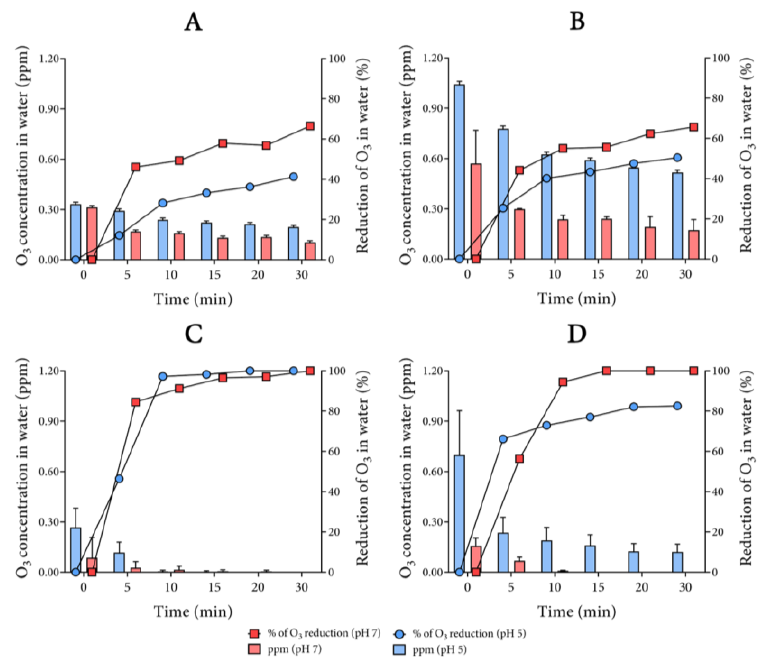
Figure 2. Ozone stability curves in ultrapure water. Ozonation of non-buffered ultrapure water at 25 °C ( A ) and 4 °C ( B ). The left y-axis is fitted the mean with standard deviation for the concentration in parts per million (ppm). The right y-axis is fitted the percentage of the O 3 reduction in water. Both displayed y-axes were obtained from the same experiment. The percentage of O 3 reduction in water was calculated considering the first sample (0 min) as the basis. Adjustment of pH was performed with 1 M HCl. Ozonation of buffered (PB, 20 mM) ultrapure water at 25 °C ( C ) and 4 °C ( D ).